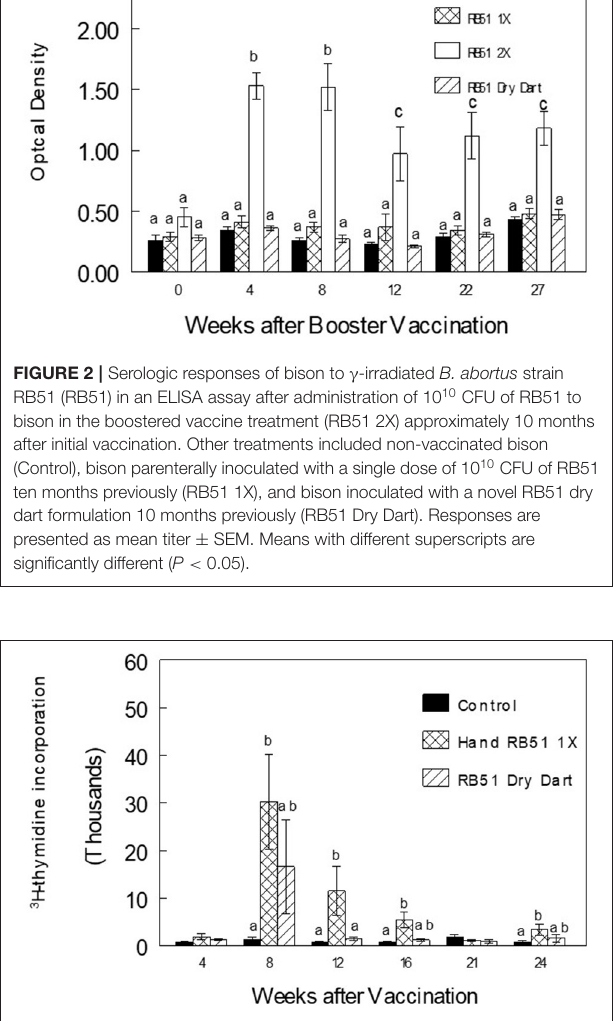
FIGURE 3 | Proliferative responses to 10 7 CFU of γ -irradiated RB51 by peripheral blood mononuclear cells from non-vaccinated bison (Control) or bison vaccinated with 10 10 CFU of RB51 parenterally or in a novel dry dart formulation. Cells were incubated at 37 ◦ C and 5% CO 2 for 7 days and pulsed for 18 hrs with [ 3 H]-thymidine. Results are expressed as mean stimulation indexes ± SEM. Means within a sampling time with different superscripts are significantly different ( P <